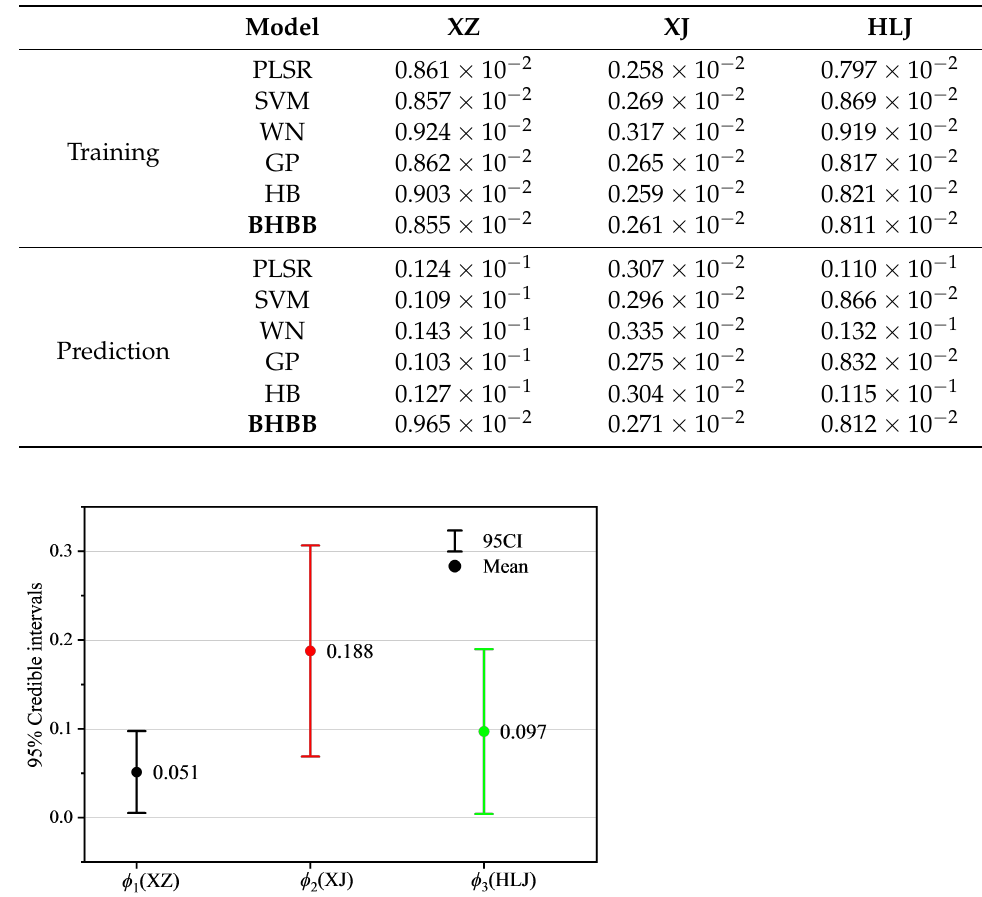
Table 3. Comparison of training and prediction RMSE results.